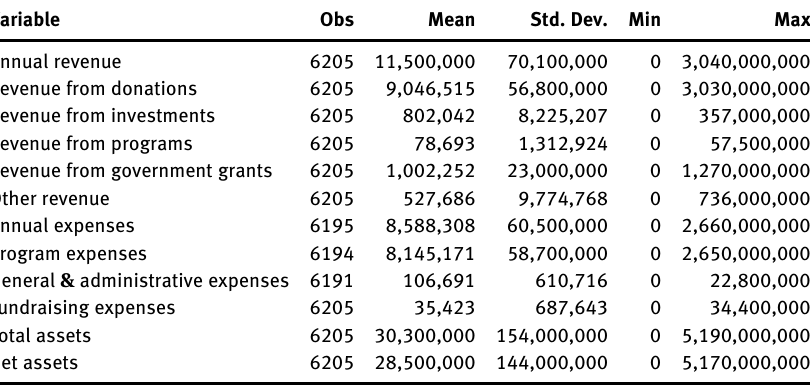
Table  : Descriptive Statistics:  –  .